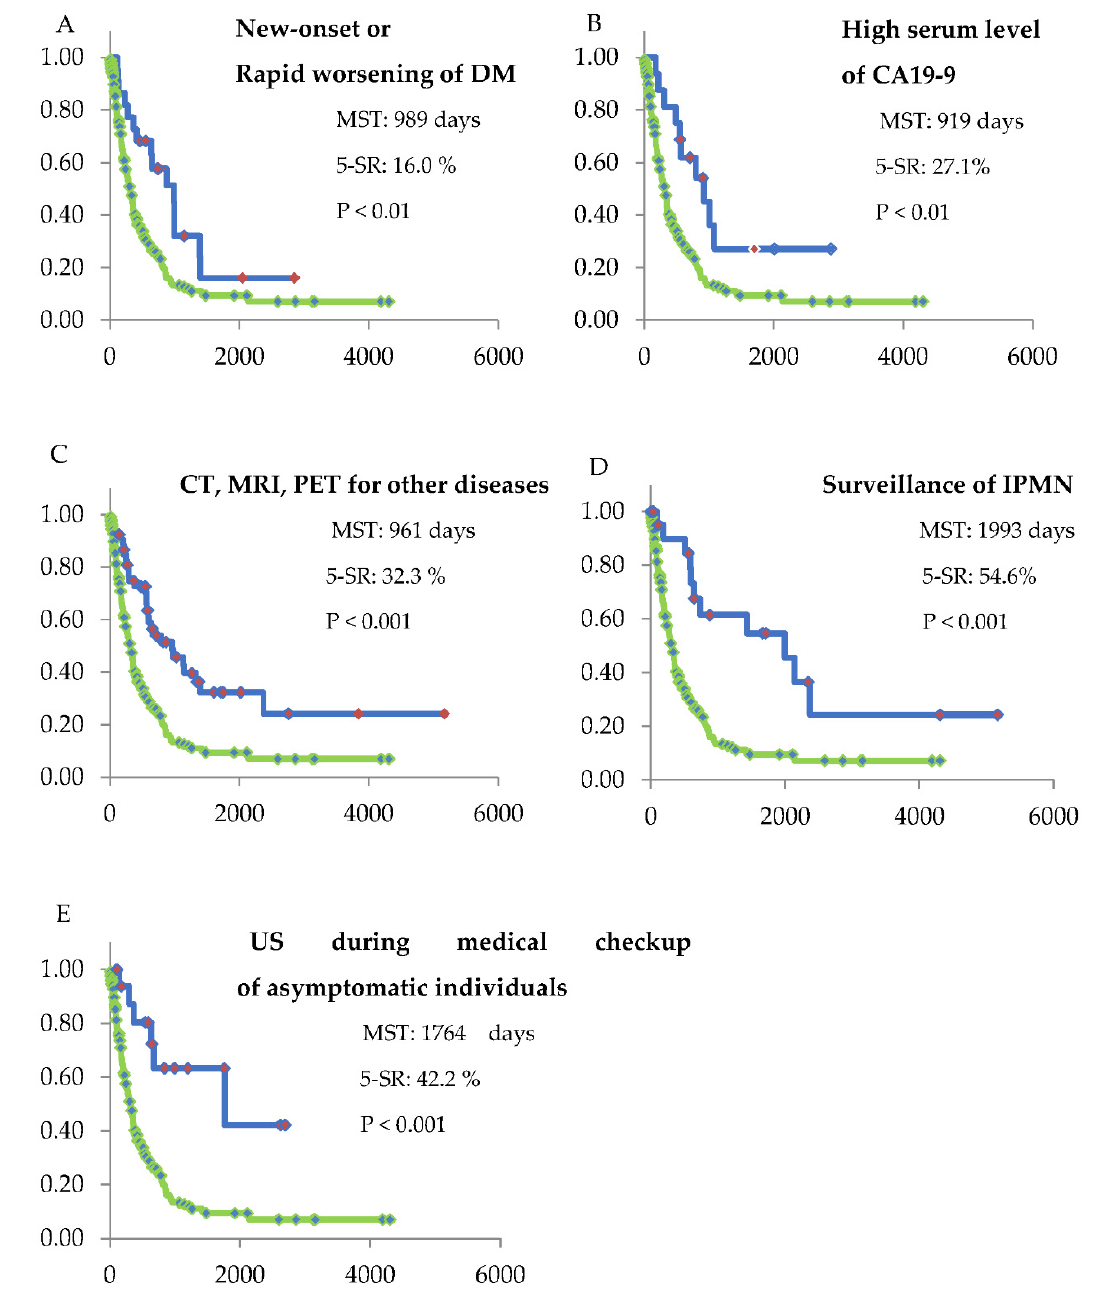
Figure 4. Kaplan–Meier curves of the symptomatic group and each of the asymptomatic groups. The green line shows the Kaplan–Meier curve of the symptomatic group. Statistical analysis for survival was performed in each group compared with the symptomatic group. The median survival time (MST), 5-year survival rate (5-SR), and the p -value are shown in each Figures (( A ): group 3, ( B ): group 4, ( C ): group 5, ( D ): group 6, and ( E ): group 7). All of the asymptomatic groups showed a significantly longer MST compared with that shown in the symptomatic group. The horizontal axis shows survival days.